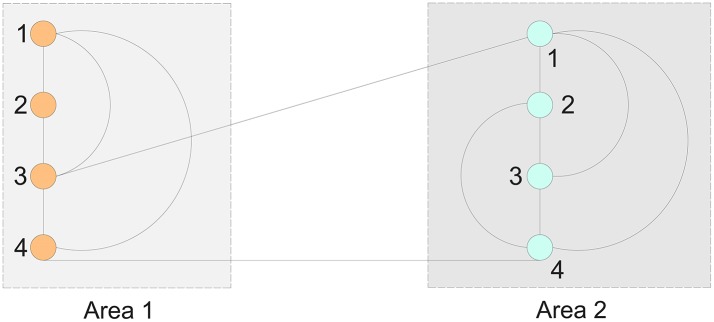
An 8-node, 2-area network.